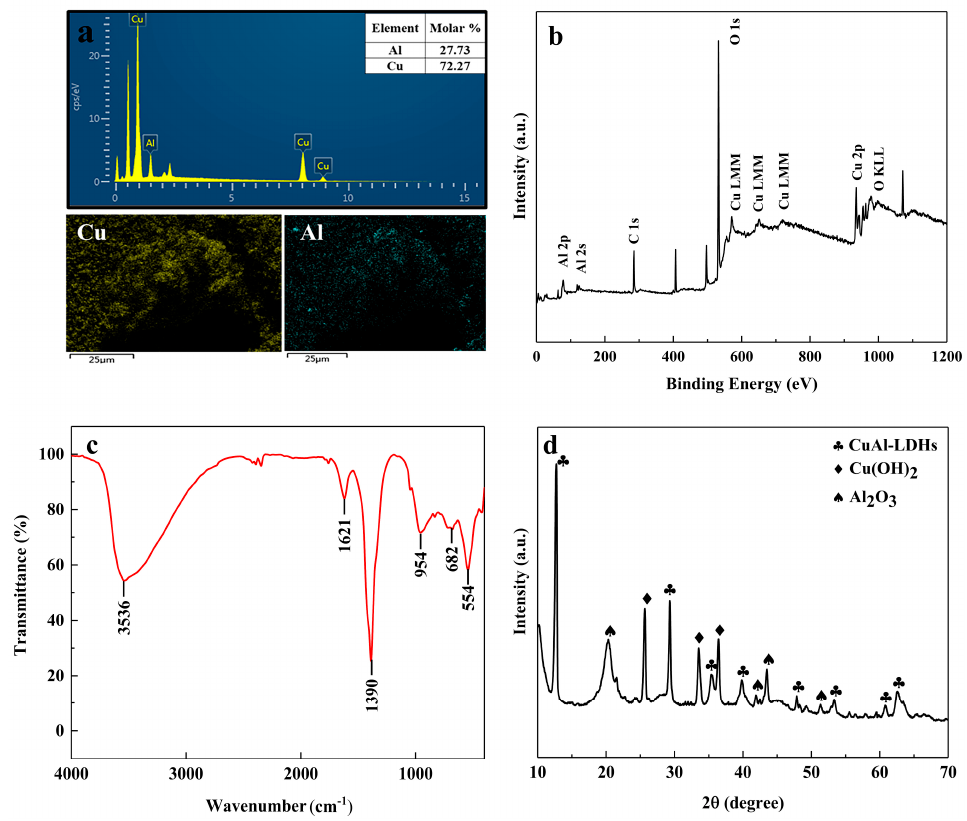
Figure 2. ( a ) Energy dispersive spectroscopy (EDS); ( b ) X-ray photoelectron spectroscopy (XPS) image; ( c ) Fourier transform infrared spectroscopy (FTIR) spectra and ( d ) X-ray powder diffraction (XRD) pattern of CuAl-LDH.